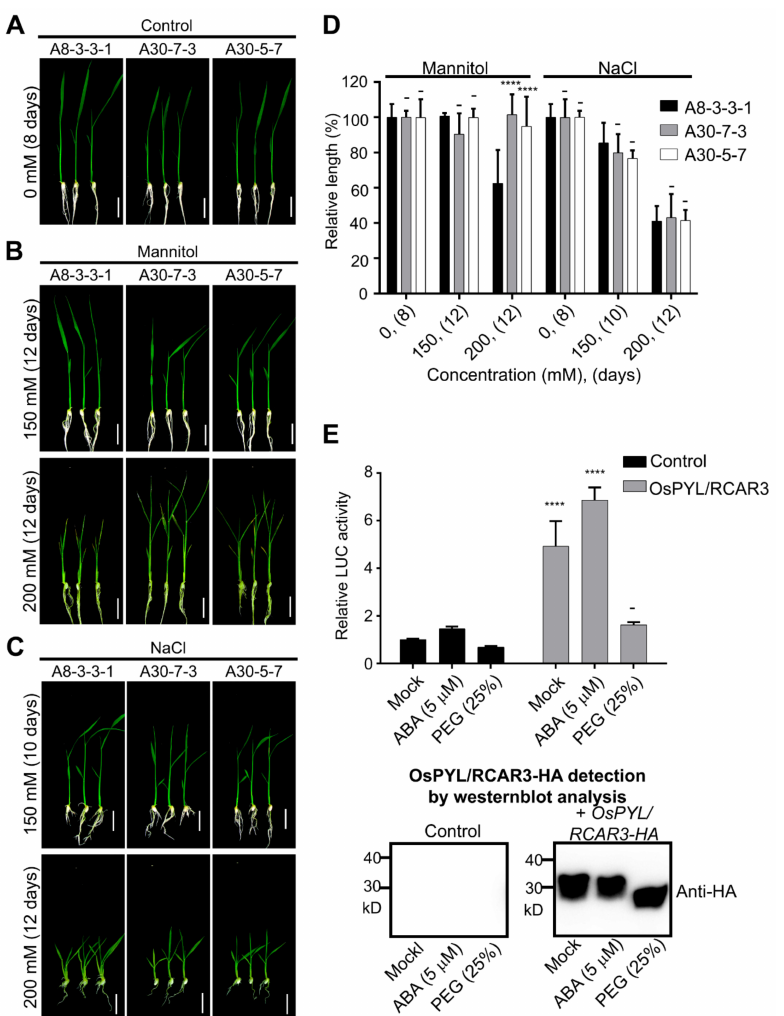
Figure 1. A30 plants, overexpressing OsPYL/RCAR3, have reduced sensitivity to mannitol-imposed osmotic stress. ( A – C ), Seedling growth test. A8 and A30 seedlings were grown in growth medium alone ( A ) or containing mannitol ( B ) or NaCl ( C ). Scale bar: 2 cm. ( D ) Measurement of relative shoot length compared to each mock (0 mM). X axis indicates mannitol or NaCl concentrations, and growth period, (in d), in brackets. Two-way ANOVA was performed with A8 plants as controls. ****: p < 0.0001, -: not significant. ( E ) Effect of OsPYL/RCAR3 overexpression on luciferase activity from the OsRab16a promoter in rice protoplasts. Control: pRab16a: LUC alone. Data presented as mean ± standard deviation (SD), n = 3. Two-way ANOVA was performed, comparing with control. ****: p < 0.0001, -: not significant. OsPYL/RCAR3-HA expression was confirmed by immunoblot analysis with anti-hemagglutinin (HA) rat